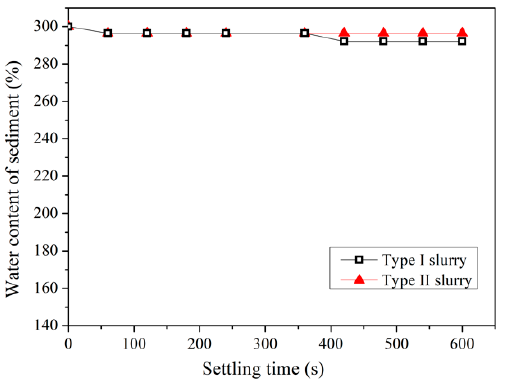
Figure 2. Sedimentation results of pipe jacking waste slurry without flocculation.